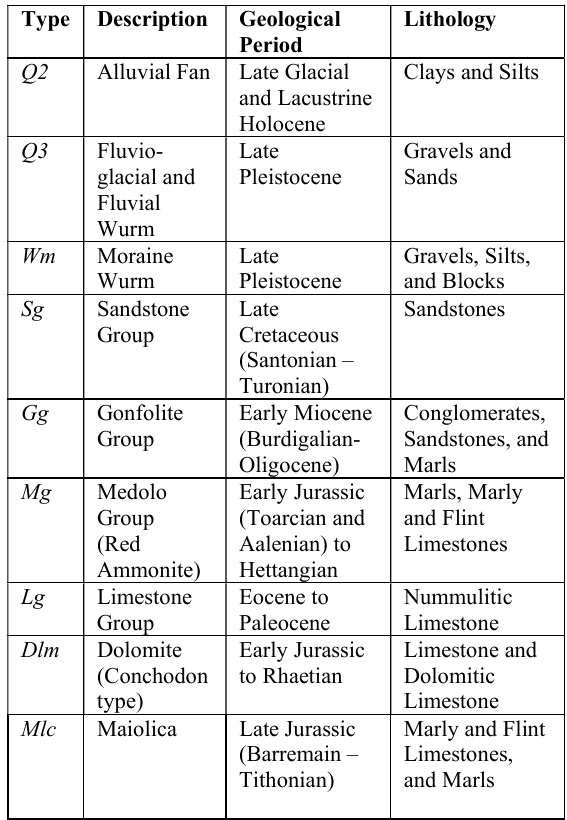
Figure 1. Case study of Como town: a) geographic location in Italy and with respect to the Lake of Como shown on a Digital Terrain Model (DTM) (Heli-Dem HD2 for Western Alpine - Biagi et al., 2016), and b) simplified geological map shown on a regional technical map (Carta Tecnica Regionale: CTR - Regione Lombardia, 2022) with a scale of 1:10,000 (reference system: WGS 84/UTM Zone 32).